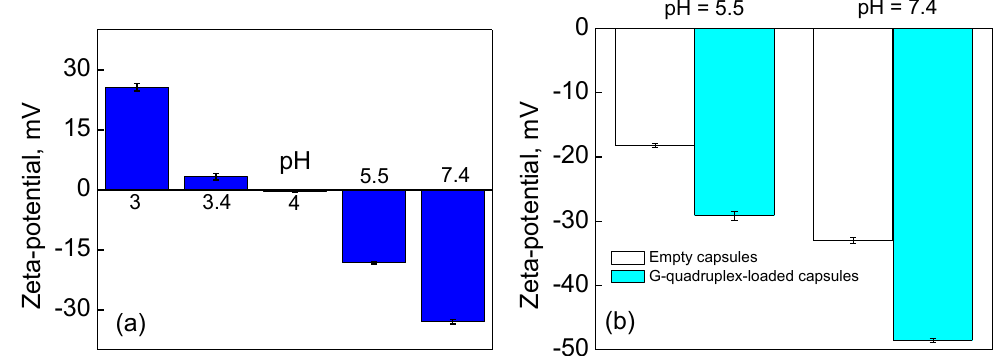
Figure 4. pH-Dependence of zeta-potential values of the (PMAA/PVPON) 13 hydrogel capsules ( a ) without G-quadruplex DNA and ( b ) loaded with G-quadruplex DNA. The data is presented as mean ± SD.